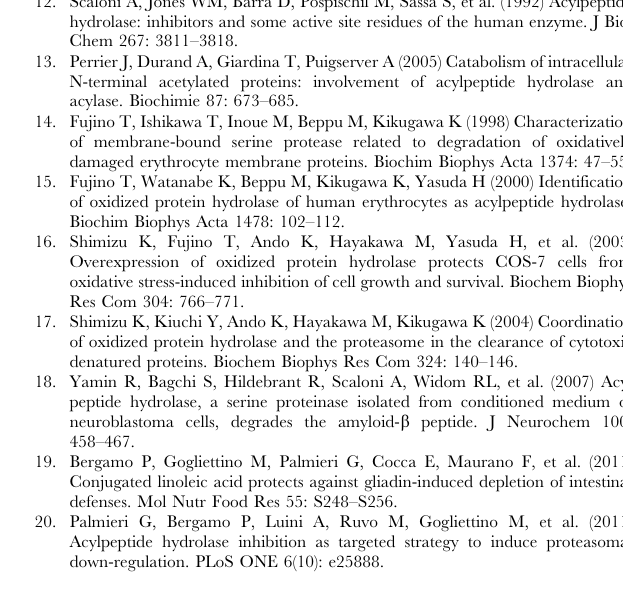
Figure S3 APEHs phylogenetic categories based on evolutionary pathways as reproduced from Krem and